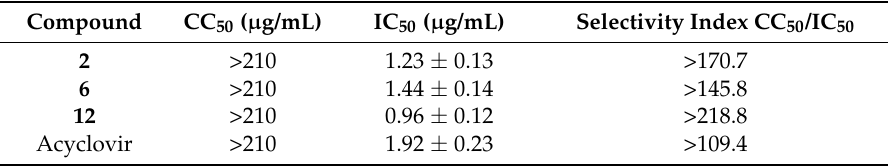
Table 1. Anti-HSV-1 activity and cytotoxicity of active compounds 2 , 6 , and 12